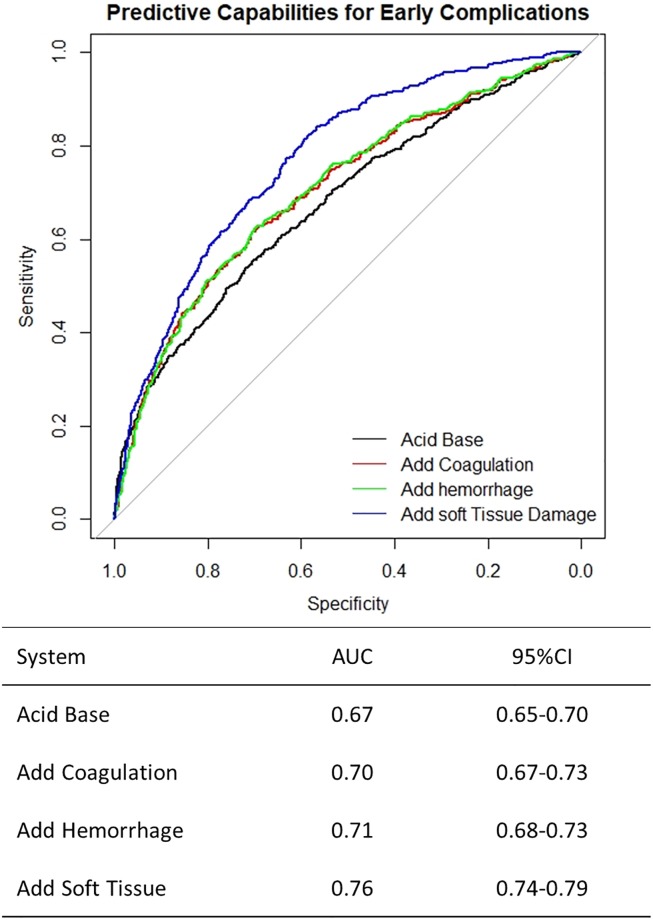
Comparison of the ability to predict early complications of acid base changes alone (black), addition of coagulopathy (red), addition of acute hemorrhage (green), and addition of soft tissue injuries (blue).The addition of these parameters lead to a sustained improvement in prediction of complications. Early Complications include Death within 72 hours, Death from traumatic brain injury, Death from exsanguination. AUC = Area Under the Curve. 95%CI = 95% Confidence Interval.